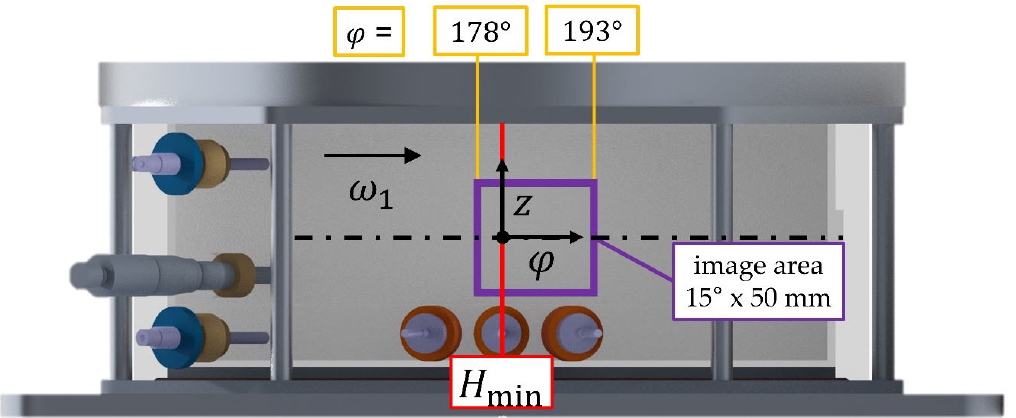
Figure 2. Optical access into the fluid film; viewing area located downstream of minimum film